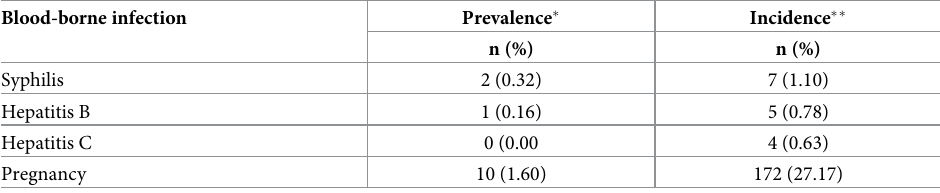
of coitarche being 12 years or younger (Table 4). Regarding the characteristics of the aggressions, the occurrence of three or more aggressors increased the chance of a diagnosis of syphilis by 14.7 times (p = 0.030) and of hepatitis B by 12.3 times (p = 0.033), in addition to increasing the chance occurrence of HPV-induced cervi- cal cytological lesion by 22.6 times (p = 0.043), when compared to violence perpetrated by one aggressor. We found 27.5% (172/653) of pregnancies resulting from sexual violence, with a higher chance of pregnancy (7.7 times, p = 0.004) between ages < = 23 and between ages 24 and 29 (6.9 times, p = 0.004) when compared to those older than 29 years of age. Among these pregnant women, 5.8% (10/172) received emergency contraception and still became pregnant; 75.0% (129/172) underwent legal abortion. Among women who were threatened, the use of firearms was associated with 5.7 times (p = 0.007) higher chance of becoming pregnant (Table 4). Table 3. Frequencies of blood-borne infections and pregnancy in women in sexual violence situations assisted by PAVI´VIS between 2010 and